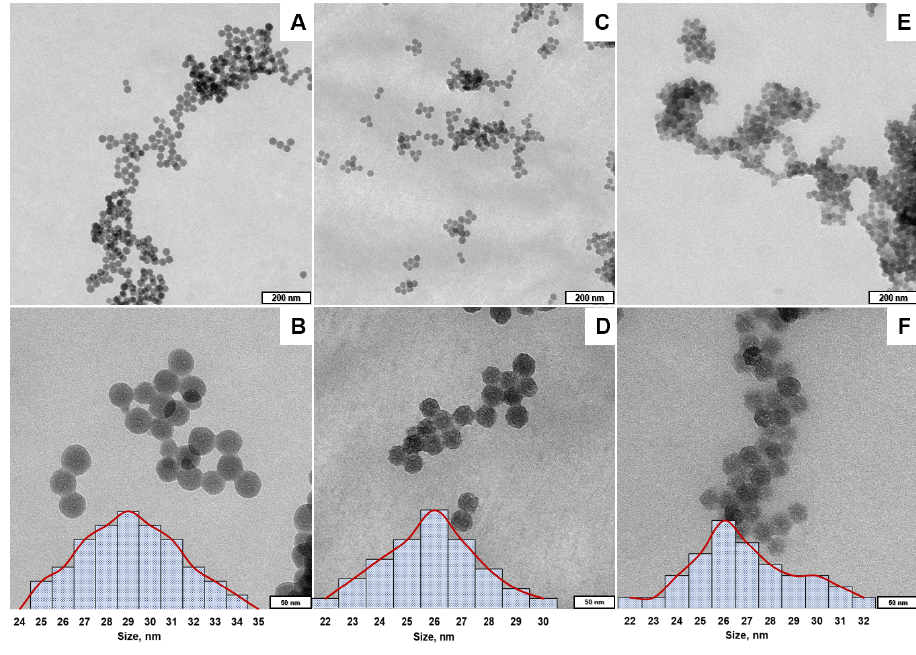
Figure 6. TEM images of silica nanoparticles with amino- and carboxymodifiers ( A , B ), luminescent composite nanoparticles before ( C , D ) and after dialysis ( E , F ).